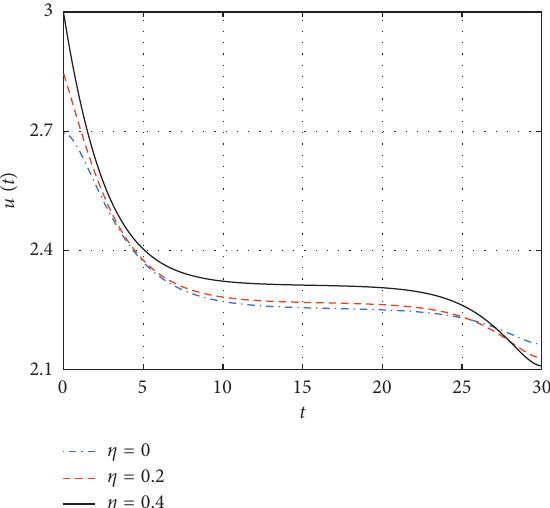
Figure 1: The optimal production strategy with different values of parameters η .